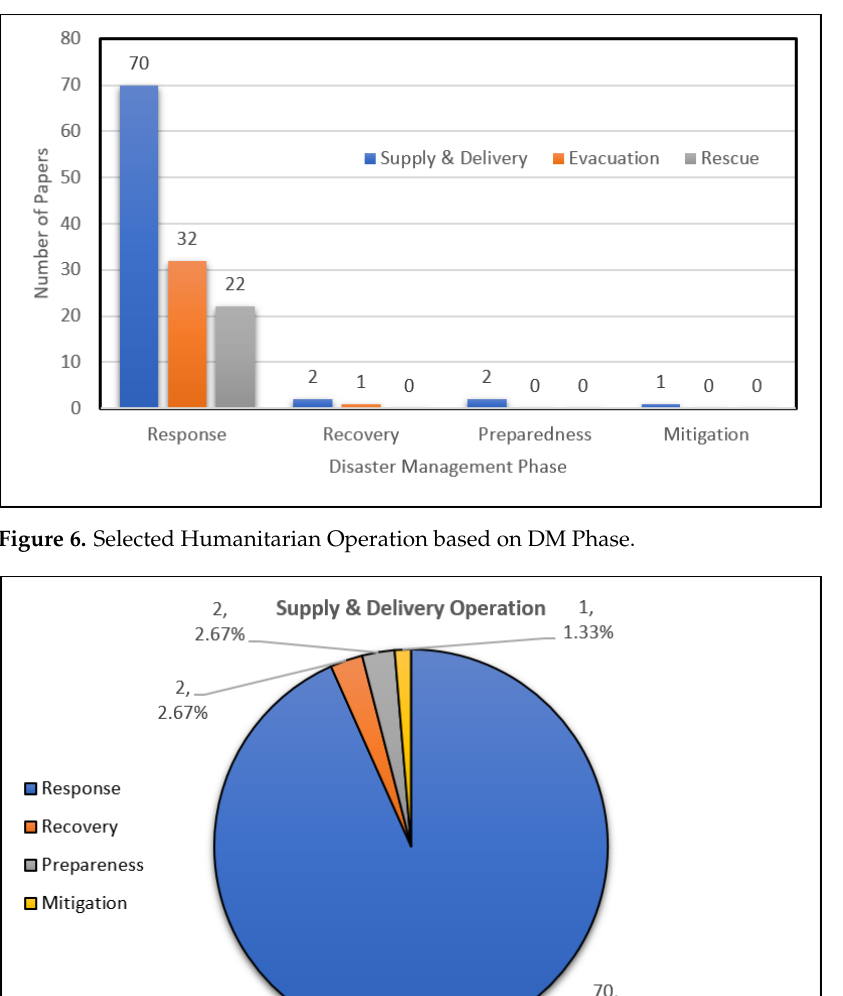
Figure 5. Breakdown of Reviewed Papers based on DM Phases.